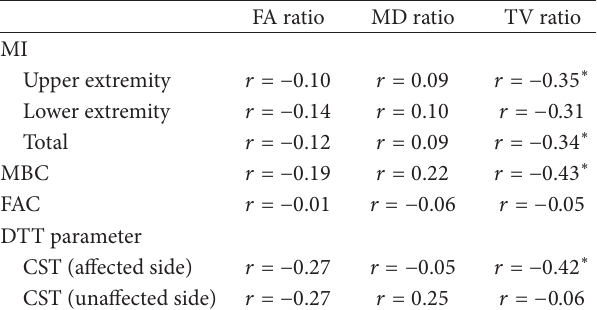
Table 3: Correlations of the ratio of diffusion tensor imaging parameters of the connectivity of the red nucleus with motor function and diffusion tensor imaging parameters of corticospinal tract. FA